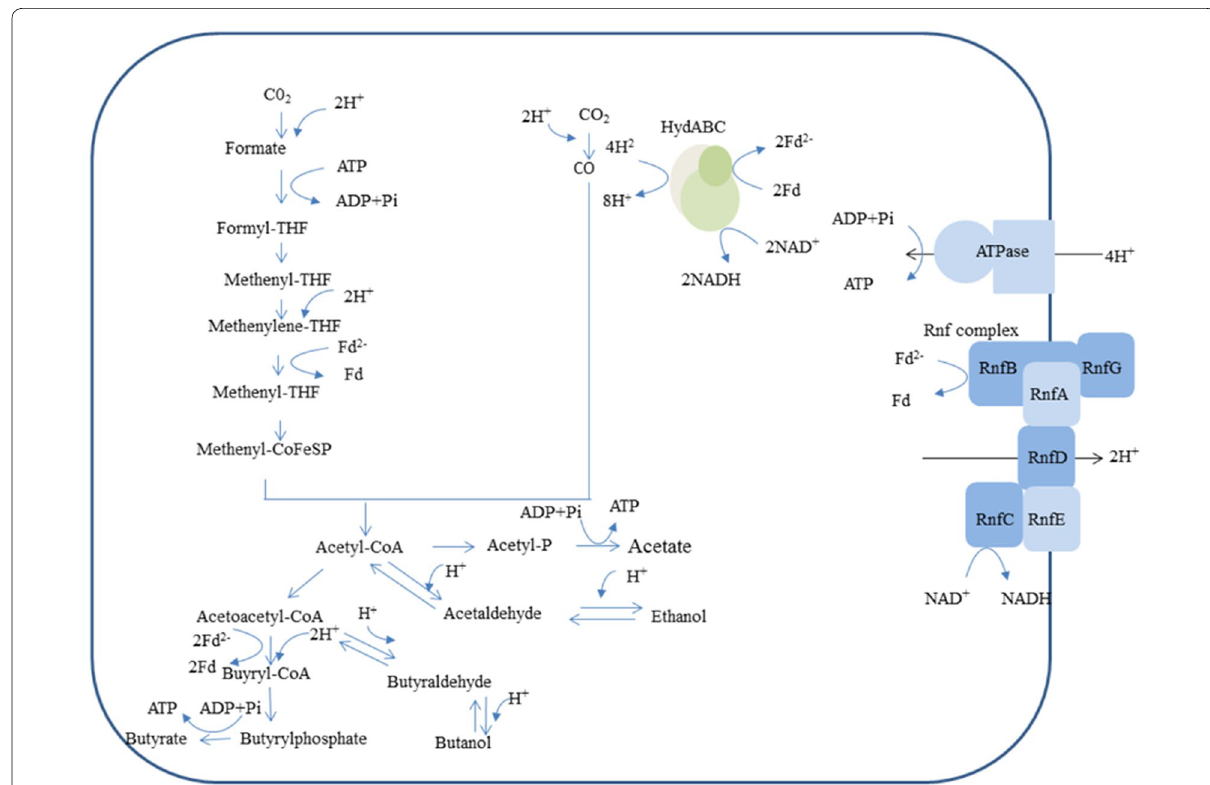
Fig. 5 The Wood–Ljungdahl pathway of C. scatologenes ATCC 25775 based on genome